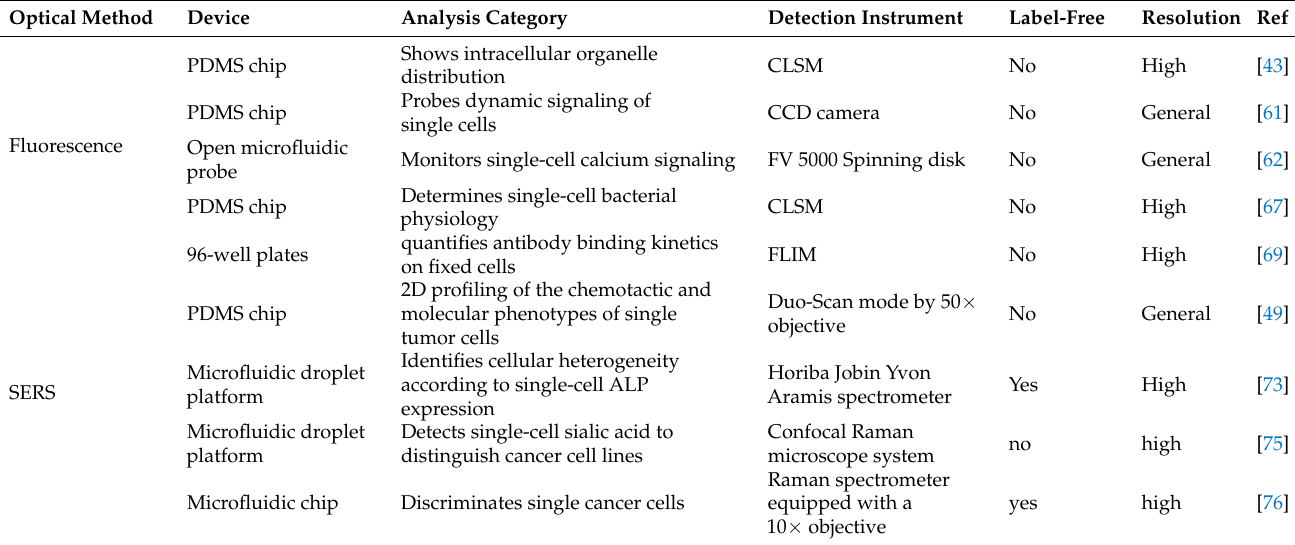
Table 1. A summary of optical technologies for single-cell analysis on